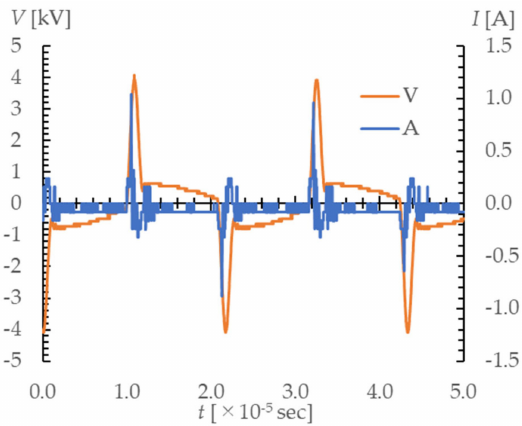
Figure 10. Oscillation status of the PA.